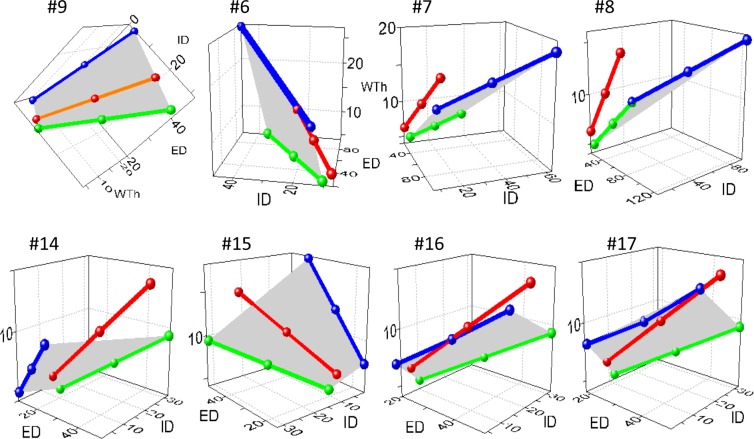
3D modeling simulation for the brain.In 3D graphs, the control equation (green lines) and each predicted variant (blue lines) are connected by the planes (grey) representing sets of all possible values that external diameters (ED), internal diameters (ID), and wall thicknesses (WTh) could acquire during transformation. The red lines represent the regression equation for hypertensive rats (S5 Table). The red lines were not congruent with any of the predicted planes, except for the variant #9. The method readily distinguishes the gradients ΔED, ΔID, and ΔWTh for the variants #6–8 and 15–17 that could only be implied in 2D graphs in Fig 13. Axis X–ED, axis Y–ID, axis Z–WTh, μm. Complementary graphs are shown in S7 Fig, S1 and S2 Videos files. Throughout the images, coordinates in some graphs were rotated at different angles to optimize display.